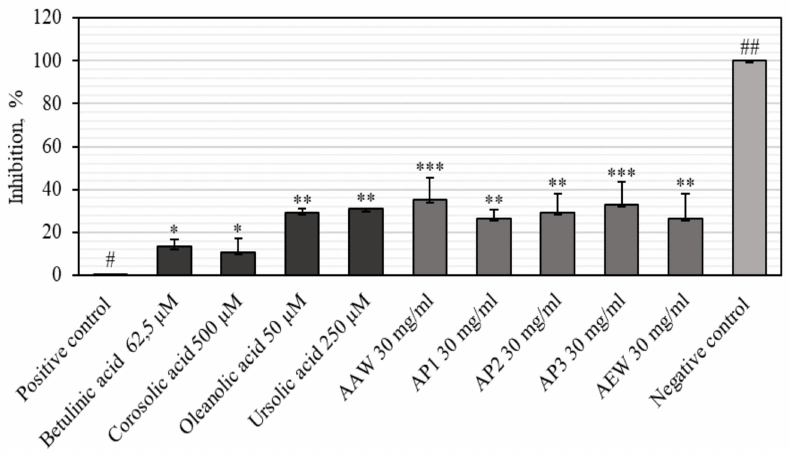
Figure 7. Hyaluronidase inhibition effect of apple extracts and individual triterpenes. Different signs (* and #) indicate statistically significant differences at p > 0.05, according to Tukey’s multiple comparison